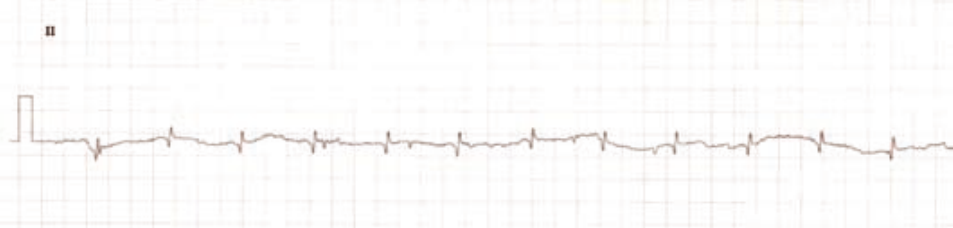
Fig. 6. ECG of animal number S5 depicting atrial standstill and sino-ventricular rhythm along with